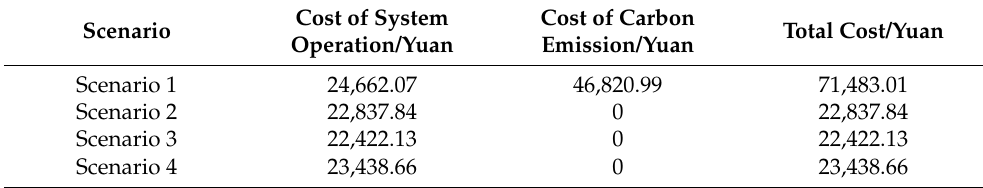
Table 1. Total cost of the system, the cost of system operation, and the cost of carbon emission under four scenarios.